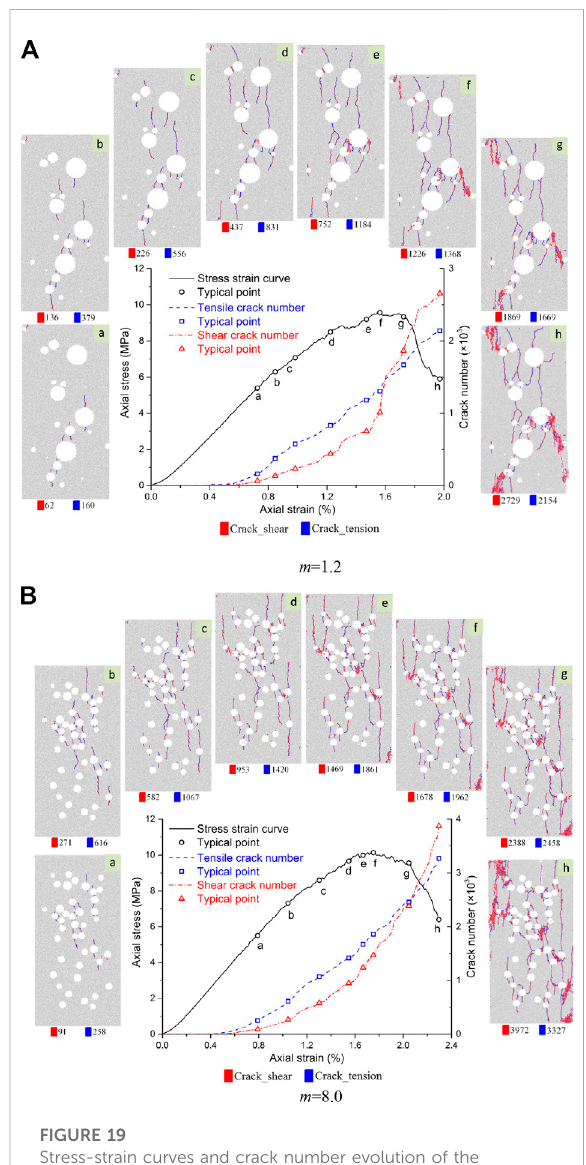
FIGURE 19 Stress-strain curves and crack number evolution of the models containing random circular defects ( p = 10%). (A) m = 1.2. (B) m =